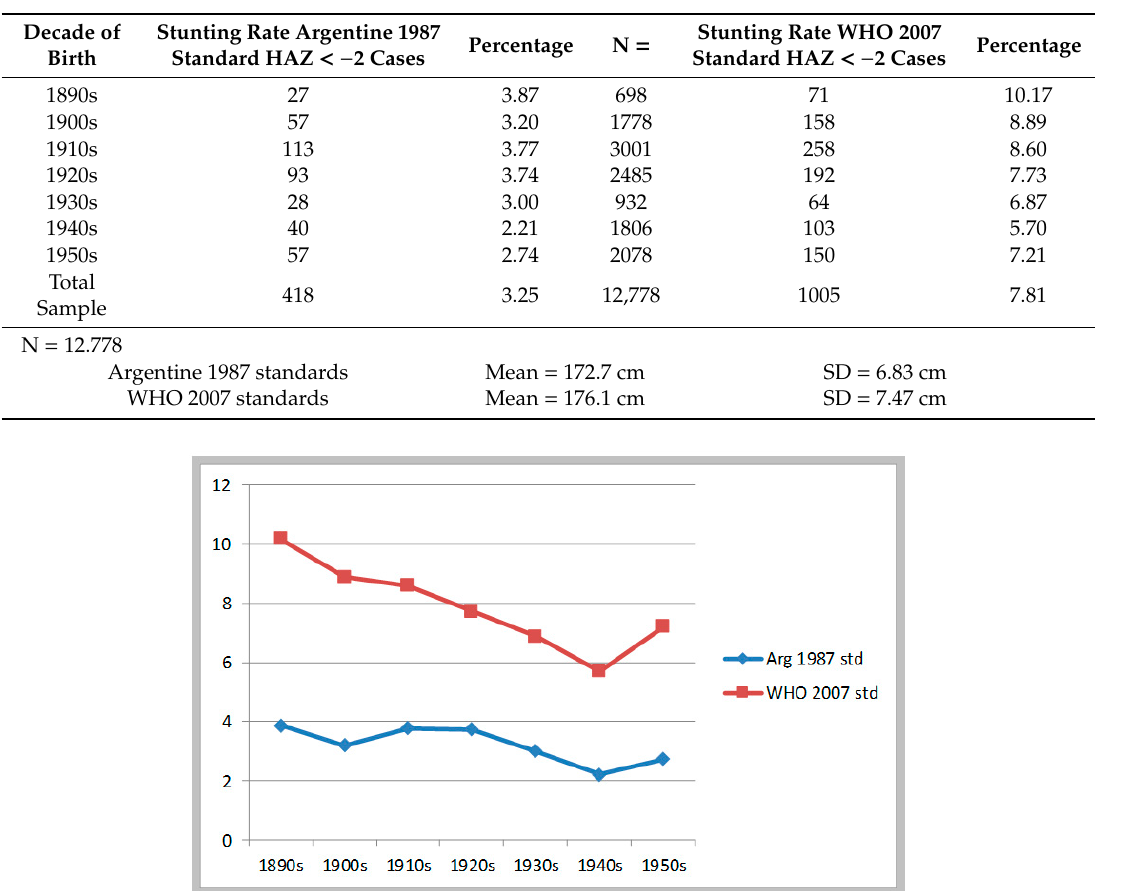
SD = 7.47 cm Figure 5. Evolution of moderate & severe stunting. Recruits from Pampa Region b.1916-1951.